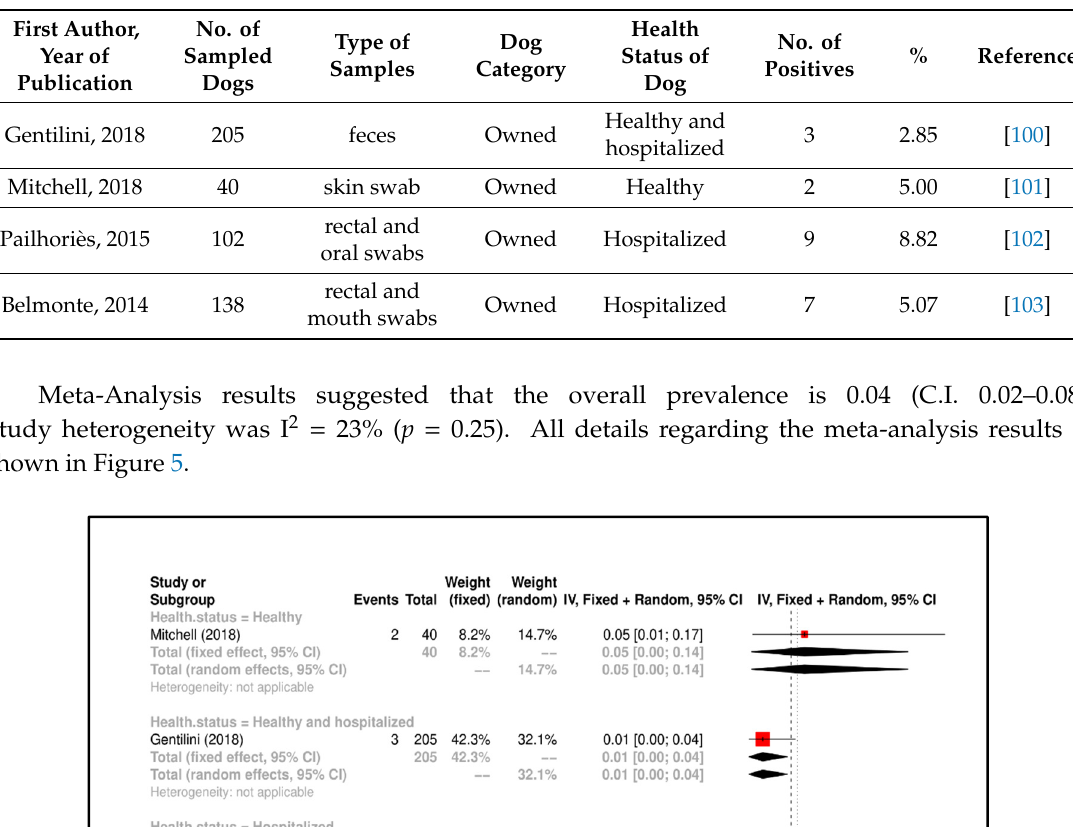
Table 5. Data of the included articles regarding the presence of Acinetobacter baumannii in dogs.